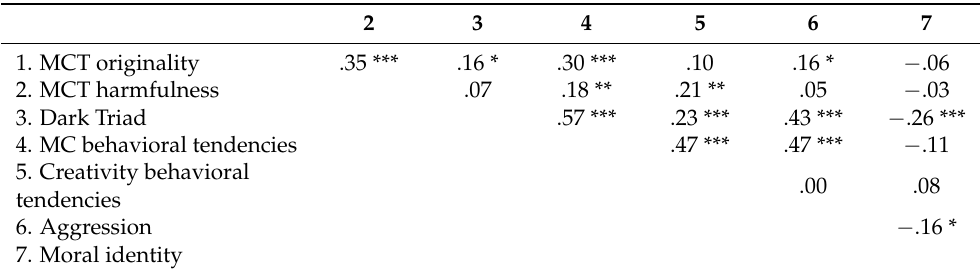
Table 1. Results of Pearson correlation analysis among all